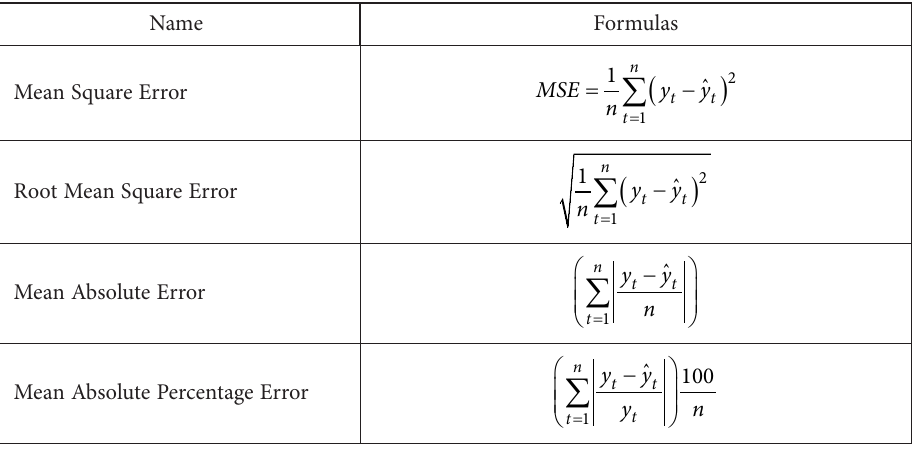
Table 1. Success criterion (corelogram)